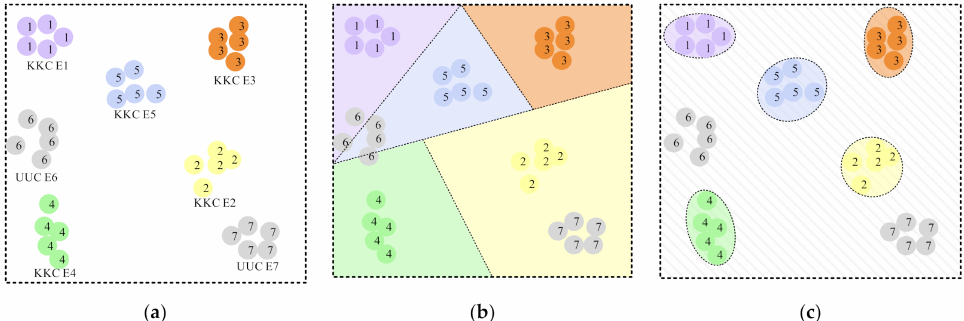
Figure 2. Plots of feature space. There exist 7 communication devices in this example, containing 5 KKC ones and 2 UUC ones. Numbers 1–7 on dots are serial numbers of individuals. Colorful dots represent KKC device features, while Gray ones correspond to UUC device features. ( a ) Plots of the entire space. ( b ) Plots of the feature space with close-set recognition bounds. ( c ) Plots of the feature space with open-set recognition